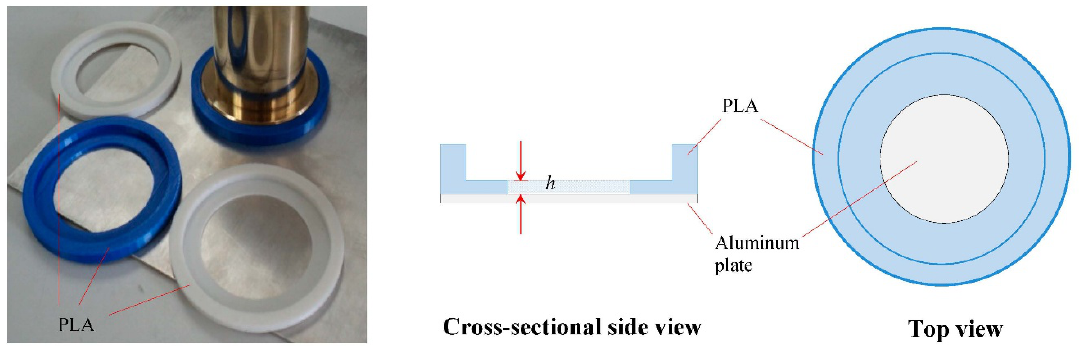
Figure 8. Printed offset short calibration kits.